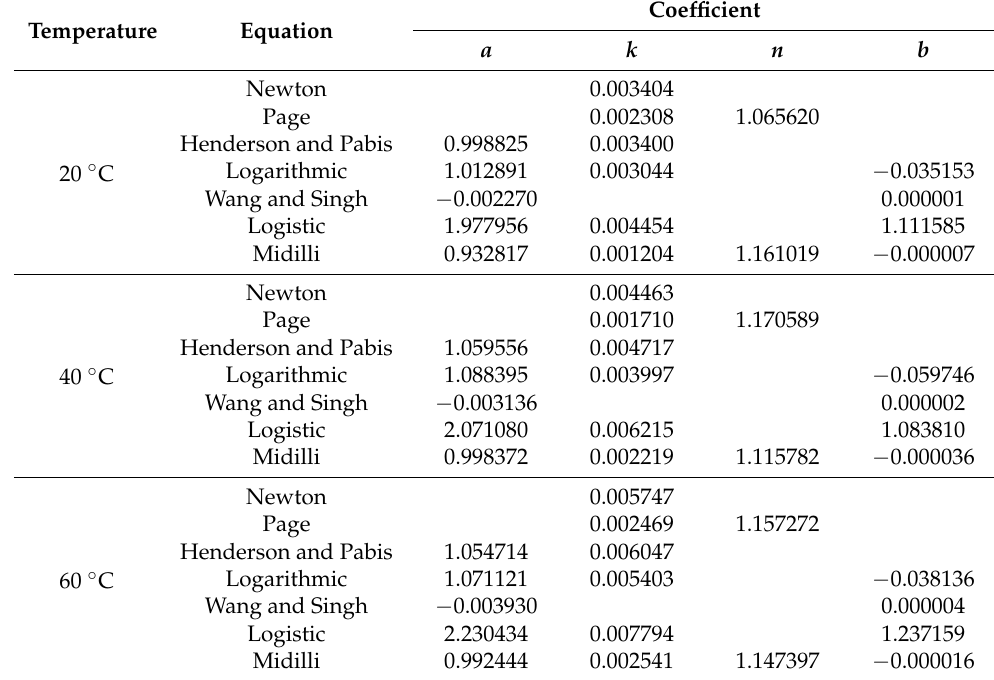
Table 4. Coefficient values in the models describing the freeze-drying of strawberry